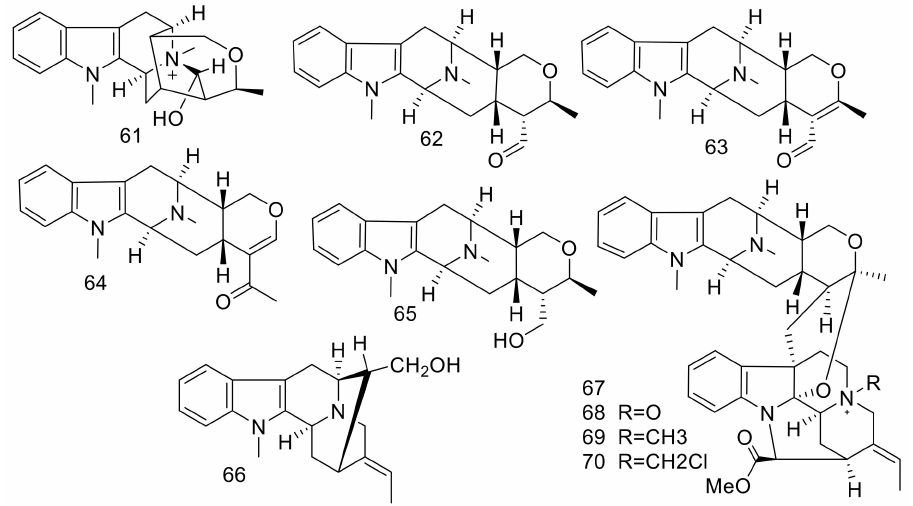
Figure 10. Compounds 61 – 70